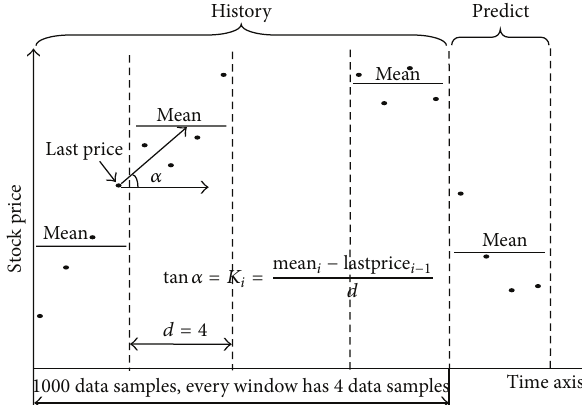
Figure 2: Illustration of features for stock price fluctuation ( 𝑑 𝑗 = 4